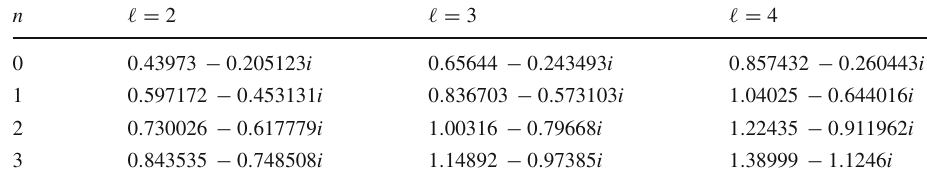
potential peak has been indicated by r 0 .The behavior of the potentials are the same up to 5.54% of difference. The unit of length along the axes is M , and the gravitational perturbations have been taken into account